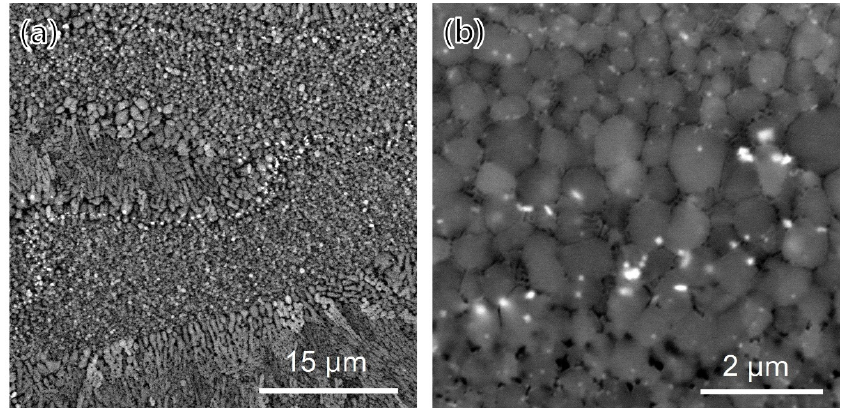
Figure 4. SEM images of ( a ) low magnification and ( b ) the fine-grain